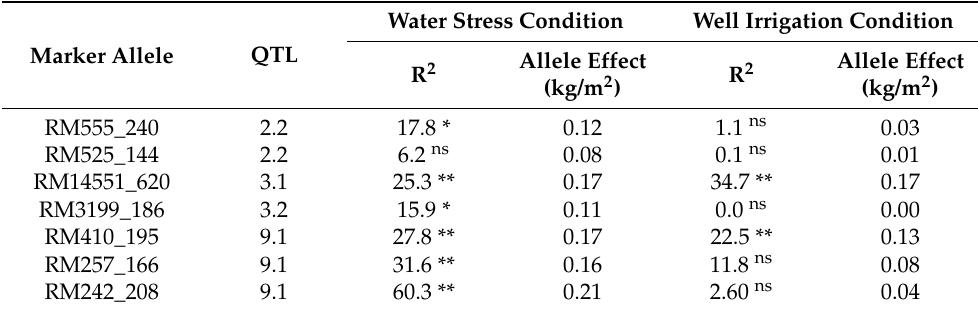
Table 4. The polymorphic markers, SMA, and common parent allele effect under well-watered and water-shortage stress